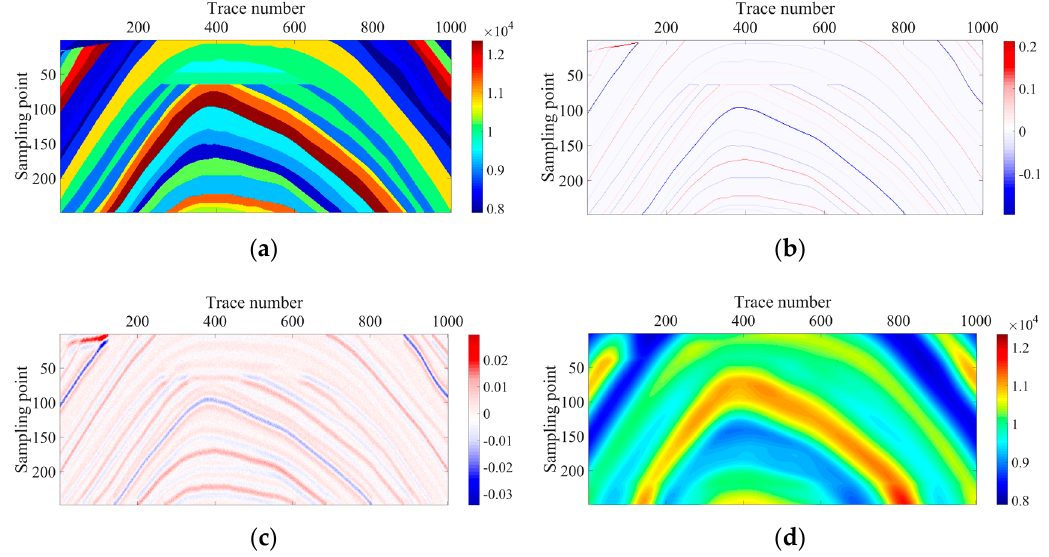
Figure 1. The part of the Marmousi2 model. ( a ) True acoustic impedance (AI) model; ( b ) Reflection coefficient; ( c ) Noisy synthetic seismic and ( d ) Initial AI model.